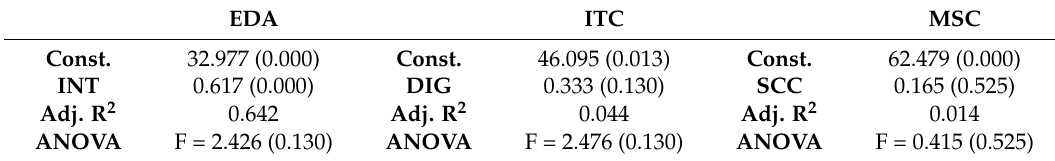
Table 3. Results from factor analysis of INT on EDA, DIG on ITC and SCC on MSC. EDA ITC MSC